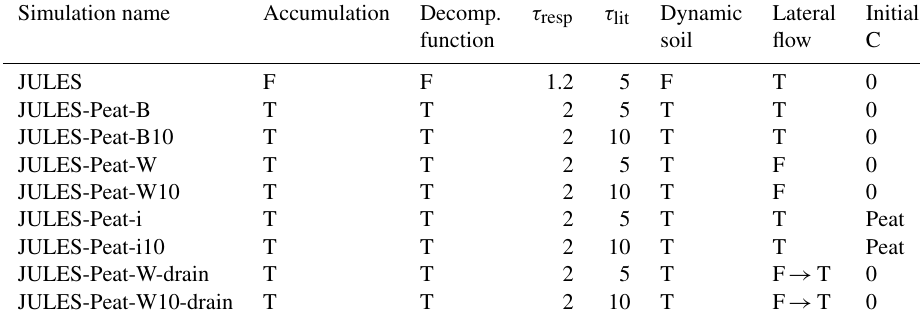
Table 2. JULES simulations conducted. Note that T means “true” (or the process is switched on) and F means “false” (process switched off). F → T mean that the process was switched off during spin-up and on during the main run. The “Decomp. function” refers to changing from the original to the new decomposition function shown in Fig. 1, and we also changed a switch that was using the total soil moisture instead of the unfrozen soil moisture, and thus the new decomposition function is a function of the unfrozen soil moisture (which is more realistic since frozen water is not available for microbes to use). Where the Initial C is given as “Peat”, we initialise all spin-ups with the spun up profile for Auchencorth from JULES-Peat-W, with ∼ 1.5m of peat, and otherwise initialise the model with zero soil carbon. Simulation name Accumulation